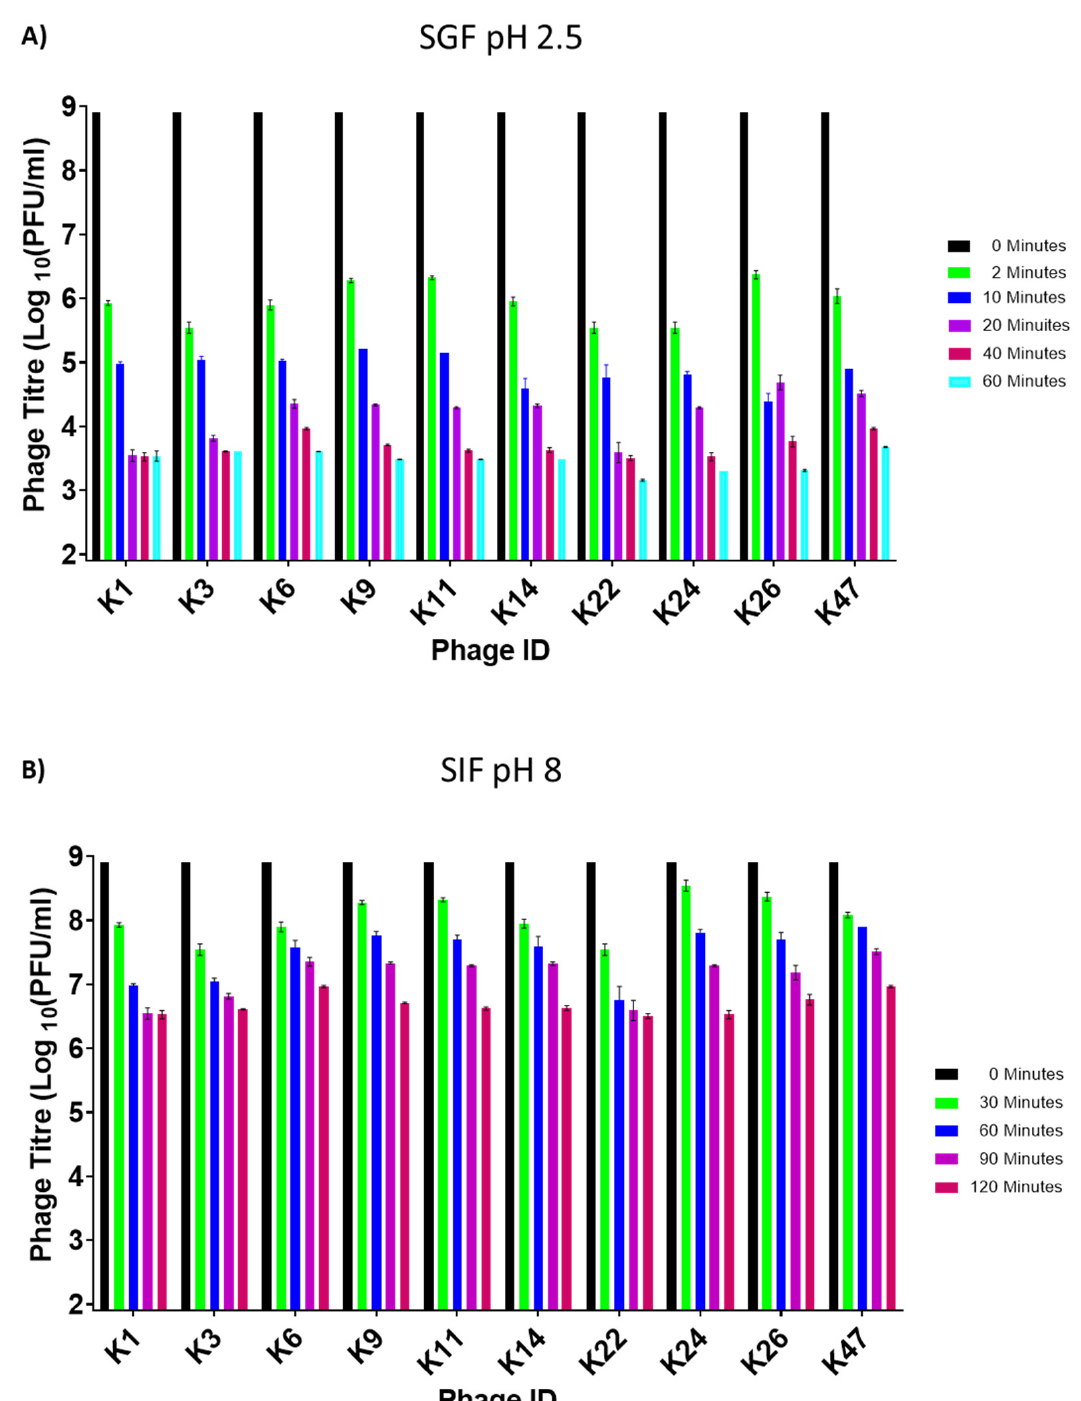
Figure 3. Phage stability in simulated gastric fluid (SGF) and simulated intestinal fluid (SIF). ( A ) Individual phage stability in SGF for 60 min of incubation at 42 °C. Phage titres for individual phages were determined after 0 (black bar), 2 (green), 10 (blue), 20 (purple), 40 (magenta), and 60 (turquoise) minutes. ( B ) Individual phage stability in SIF for 120 min of incubation at 42 °C. Phage titres for individual phages were measure after 0 (black bar), 30 (green), 60 (blue), 90 (purple), and 120 (magenta) minutes. All experiments were repeated twice and measured in triplicate. Each bar indicates phage titres at specific times. Error bars represent the standard error of the mean (±SE).